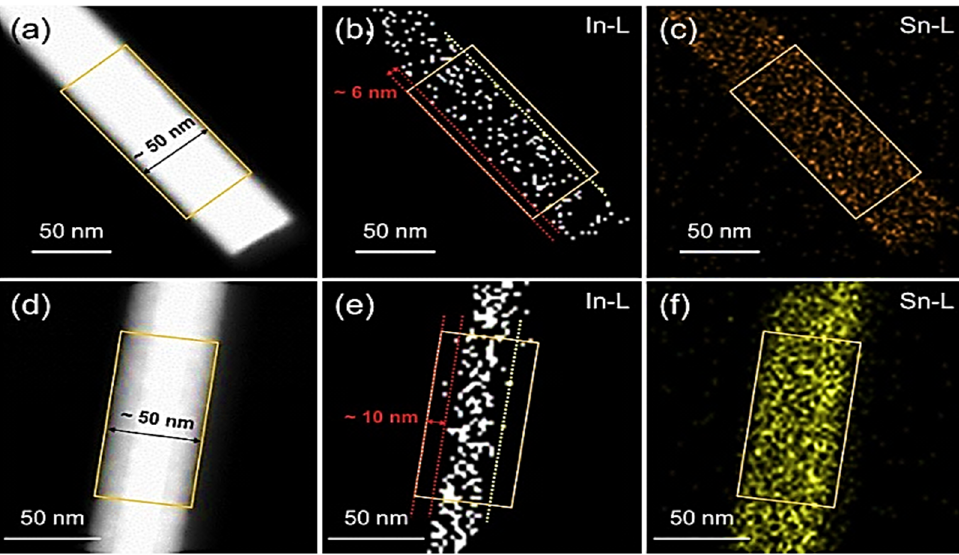
Figure 27. EDS color mapping images showing distribution of In and Sn elements of In-implanted SnO 2 NWs at a dose of ( a – c ) 2 × 10 14 ion/cm 2 and ( d – f ) 1.8 × 10 15 ion/cm 2 Reproduced from [136] with the permission of Elsevier.